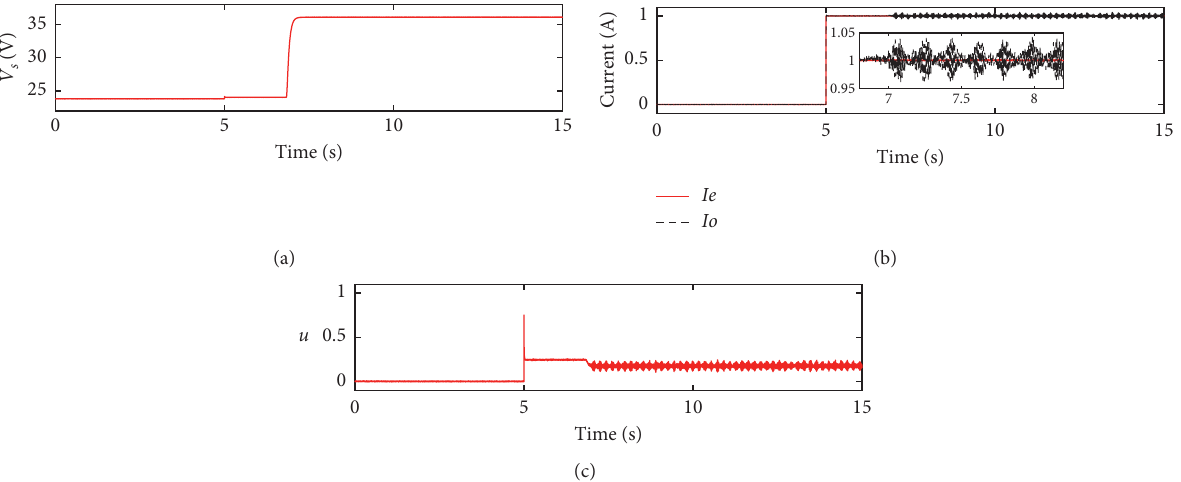
Figure 20: The results of the system using PI controller with V